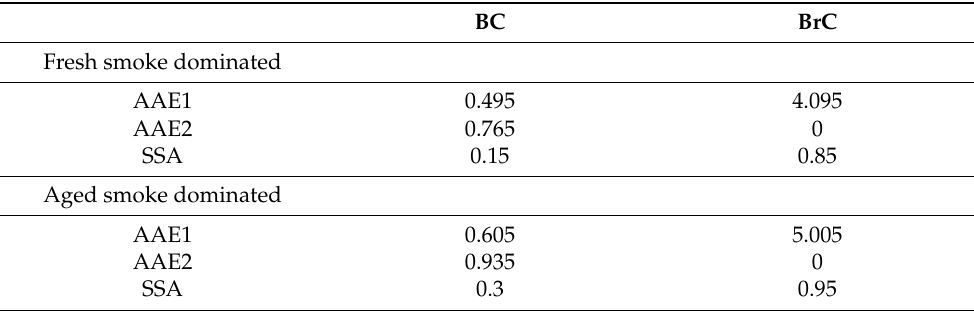
Table 4. The values of AAE and SSA used for fresh and aged smoke conditions for BC and BrC. BC BrC Fresh smoke dominated AAE1 0.495 4.095 AAE2 0.765 0 SSA 0.15 0.85 Aged smoke dominated